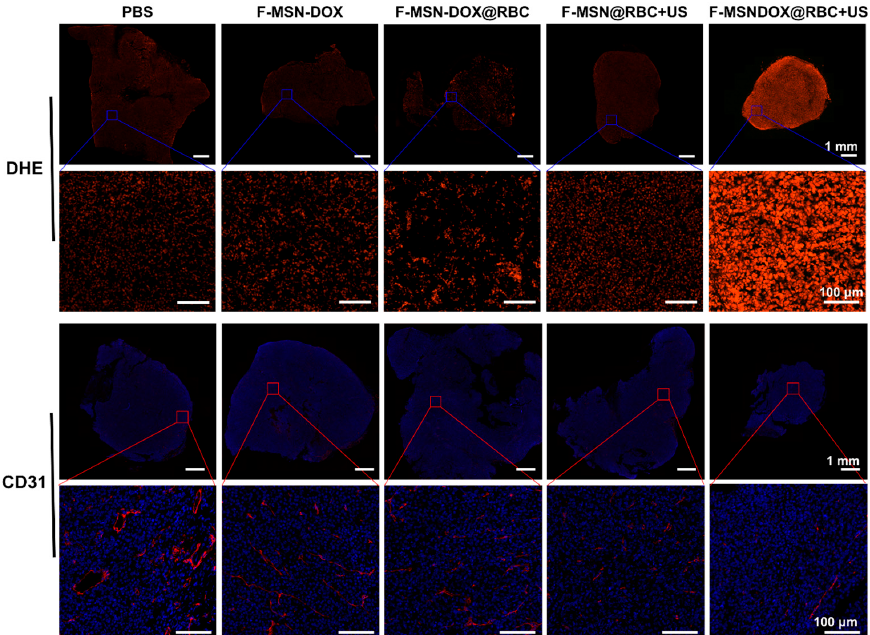
Figure 7. DHE and CD31 immunofluorescence staining of the ROS and blood vessels of RM-1 tumor. The scale bar is 1 mm in the upper row and 100 µm in the lower row.